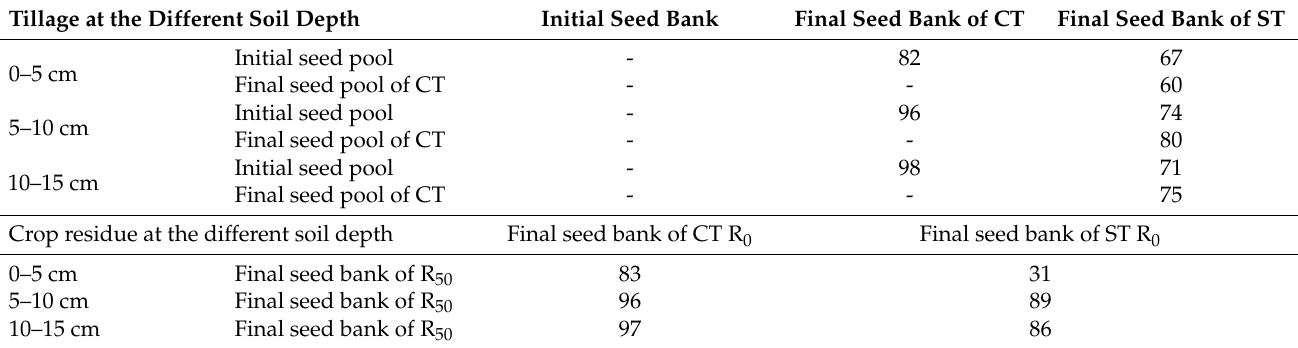
Table 7. Effect of tillage practices and residue levels on the Sørensen’s similarity index (%) of the initial and final seed bank. Tillage at the Different Soil